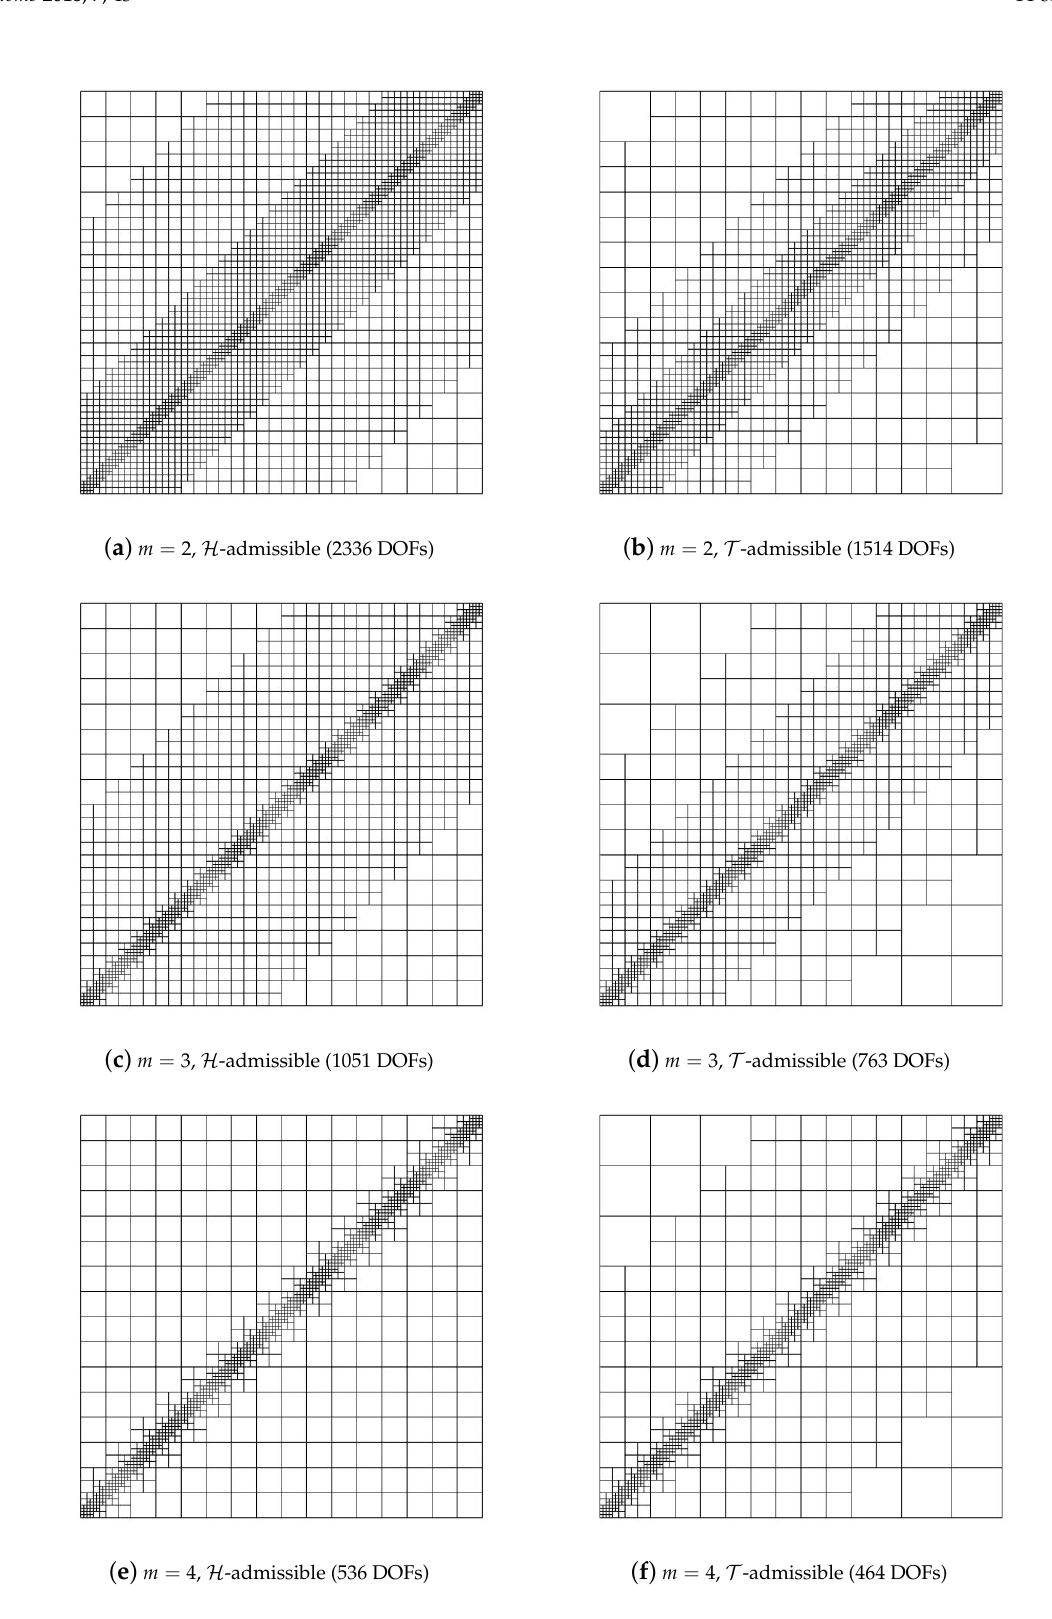
Figure 4. Hierarchical meshes obtained with p = ( 3,3 ) and m = 2,3,4 (from top to bottom ), by using H -admissible ( left ) and T -admissible ( right )